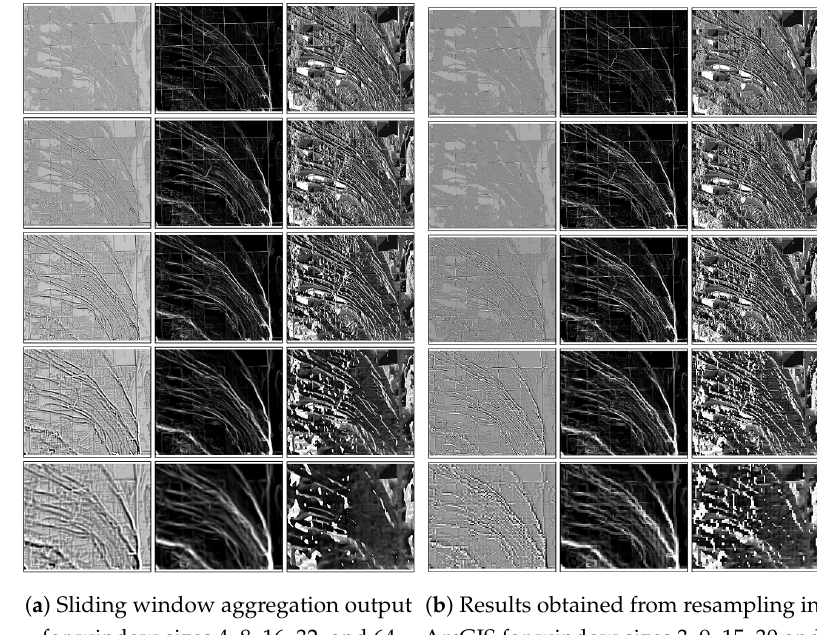
Figure 7. Digital elevation model (DEM) obtained from both methods. The GIS attributes shown include Curvature, Slope and Aspect from